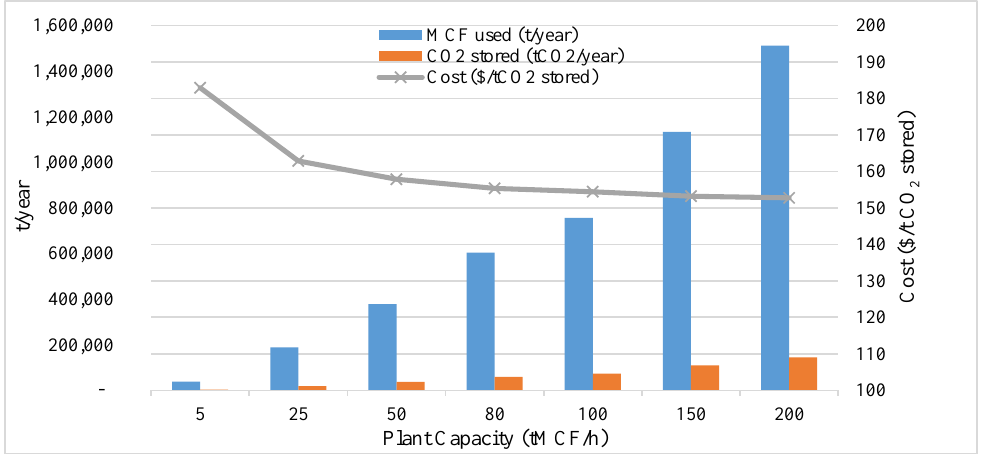
Figure 3 . Quantity of MCF used, CO 2 stored per year and OPEX as function of the carbonation plant capacity.